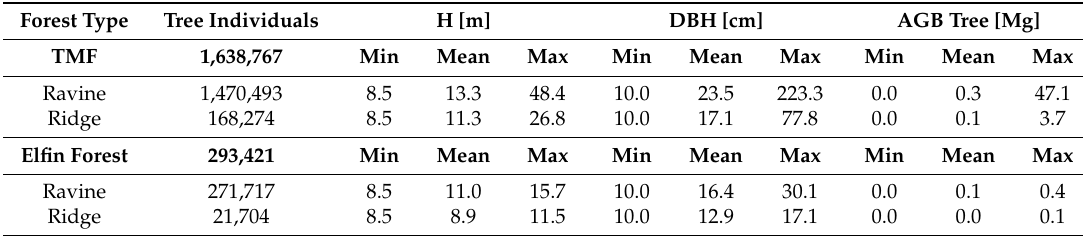
Table 2. Mean and extreme values of H, DBH and AGB for individual trees in the TMF and the Elfin Forest.